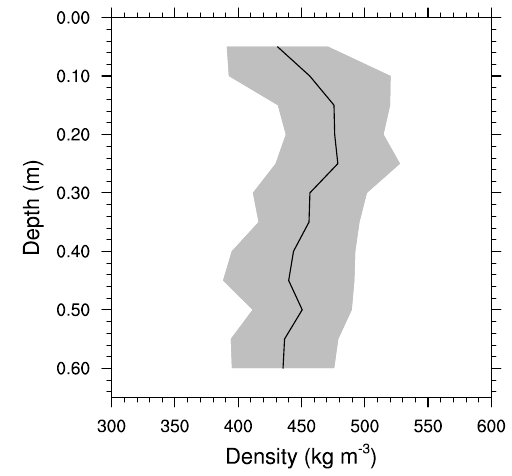
Fig. 3. Measured density profiles between 0 and 0.60 m depth below the surface. The black line is the mean and the grey area represents one standard deviation of 60 density profiles measured between 16 and 28 January